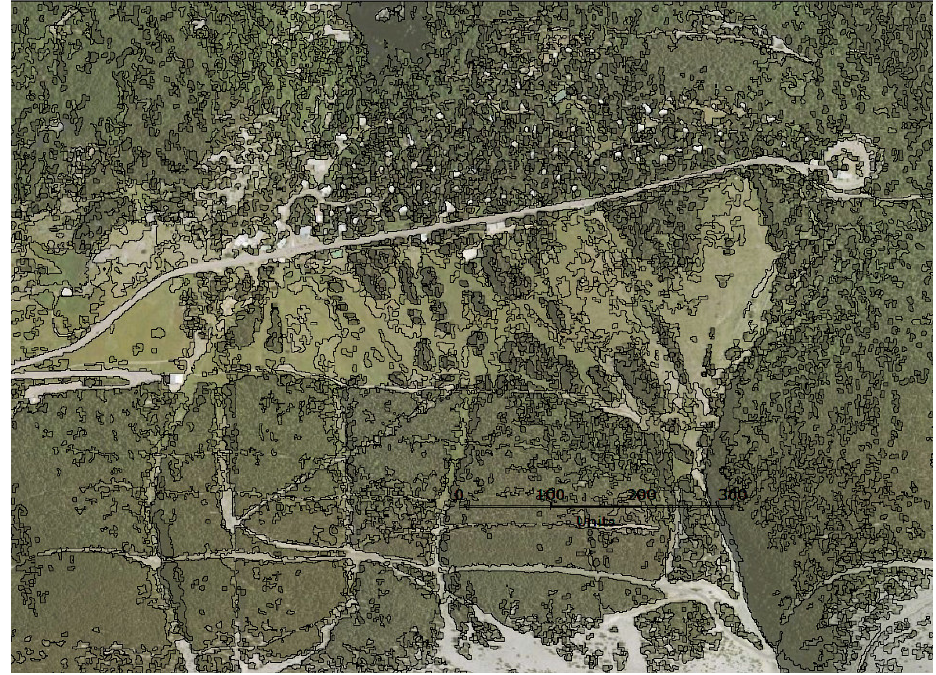
Figure 6. Segmentation obtained using Self Organizing Map (SOM-2-2-15) with the following parameters: radius = 2, alpha = 2 and K = 15